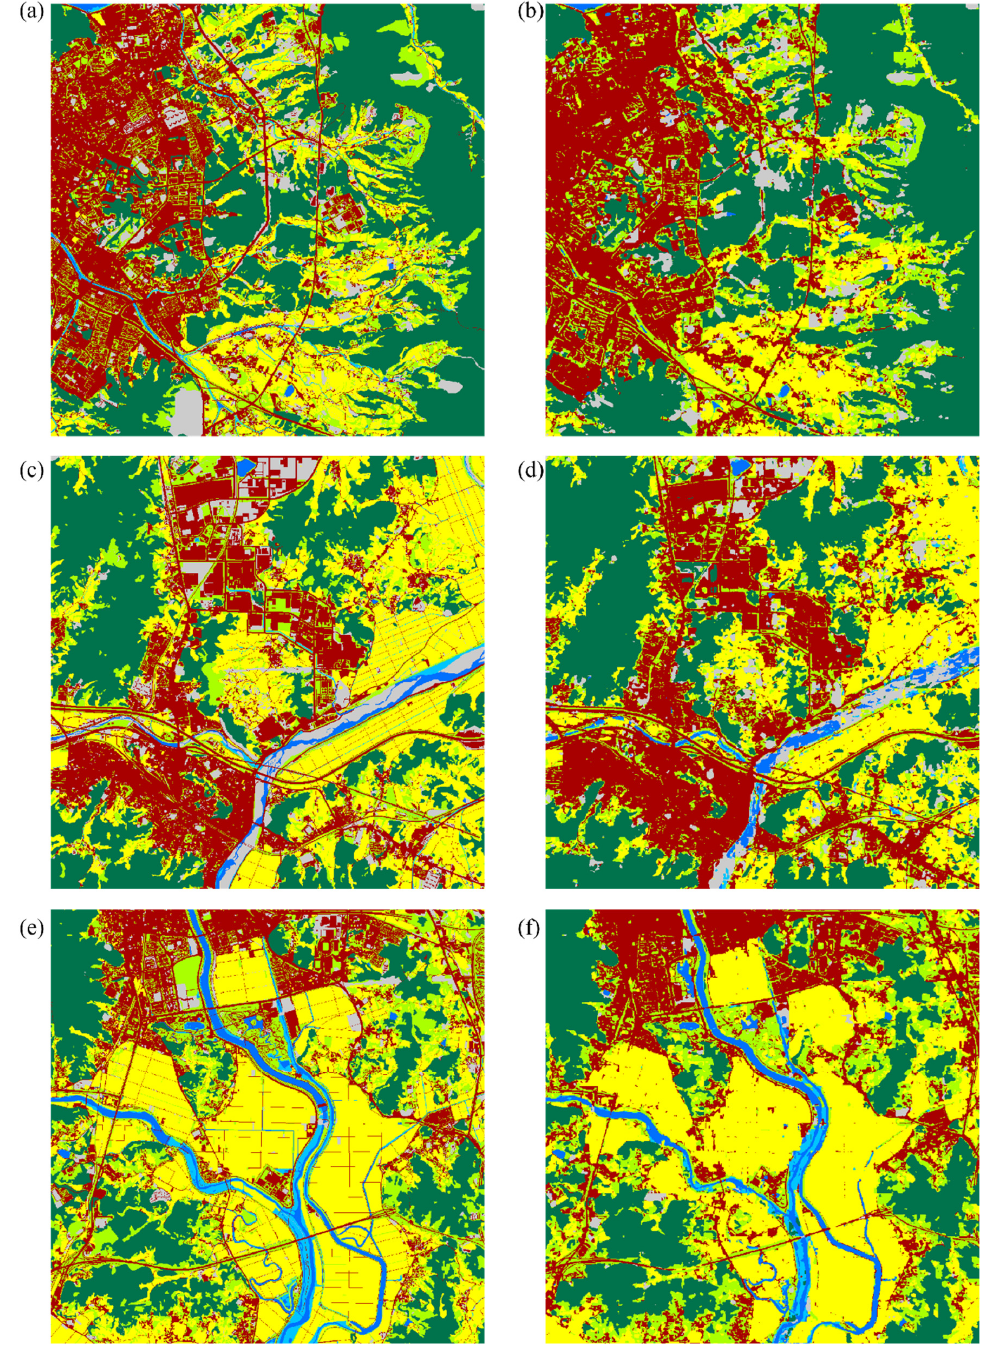
Figure 5. The detail land cover map in the study area for ( a ) label image in Chuncheon, ( b ) output image of deep learning model in Chuncheon, ( c ) Label image in Gimcheon, ( d ) output image of deep learning model in Gimcheon, ( e ) Label image in Suncheon, ( f ) output image of deep learning model in Suncheon. As for the consistency between the land cover map constructed by applying the op ‐ timal model and the Sd LCM, the OA and kappa coefficient for the three cities indicated